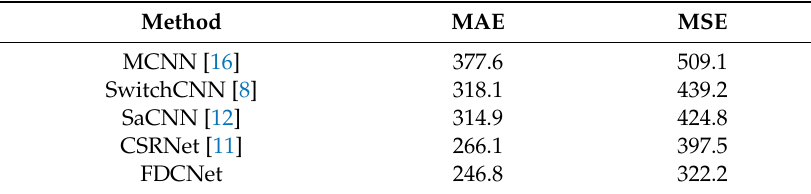
Table 3. The estimation errors on UCF_CC_50 dataset.